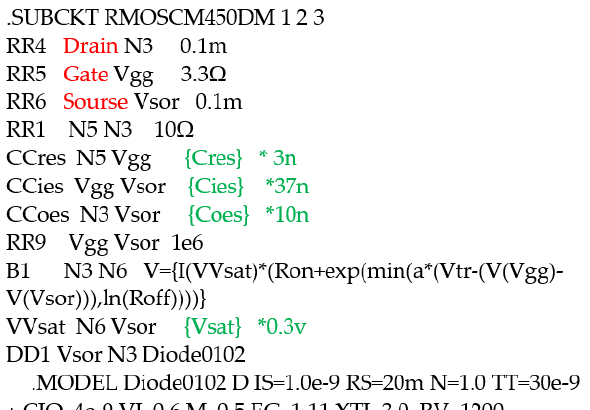
Figure 18. Model of CM450DX-24S1.